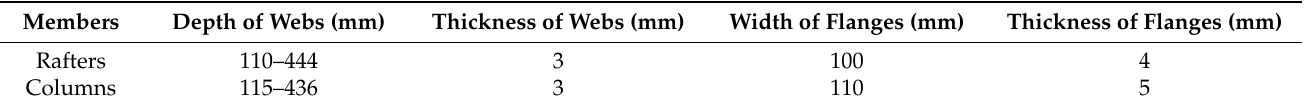
Figure 2. Gabled frame model. ( a ) Three-hinged gabled frame; ( b ) 1/2-bay gabled frame.